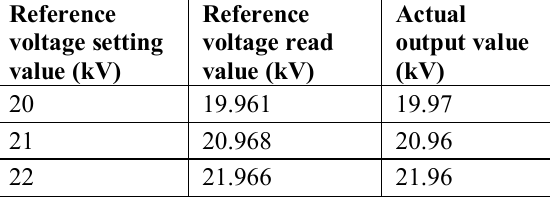
Fig. 4. The architecture of ASIPP anode power